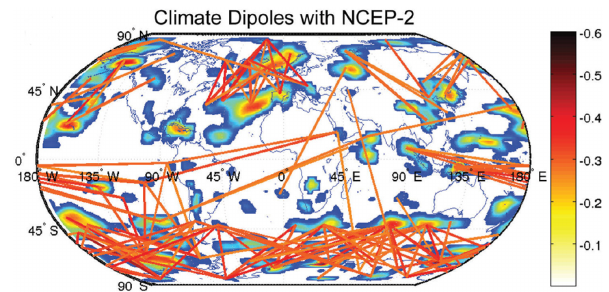
Figure 6. Node-link diagram with split edges: dipoles extracted from the sea level pressure field (SLP) from NCEP2 reanalysis data, and edge shared reciprocal nearest neighbour density mapped to colour (reprinted from Ganguly et al.,